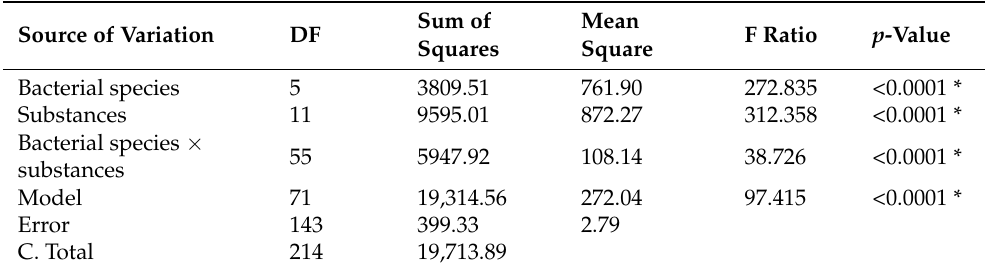
Table 3. ANOVA results to test the diameter of the zone of inhibition between the substances (essential oil and antibiotics) and the bacterial species.